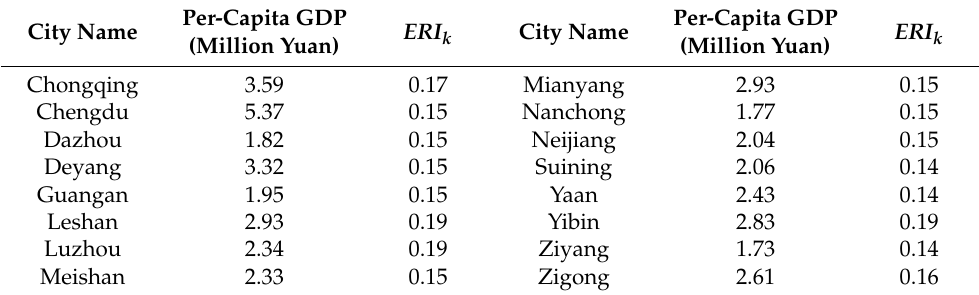
Table 2. Per-capita GDP and ERI k statistics for the 16 cities based on the three-year average (2000, 2010, and